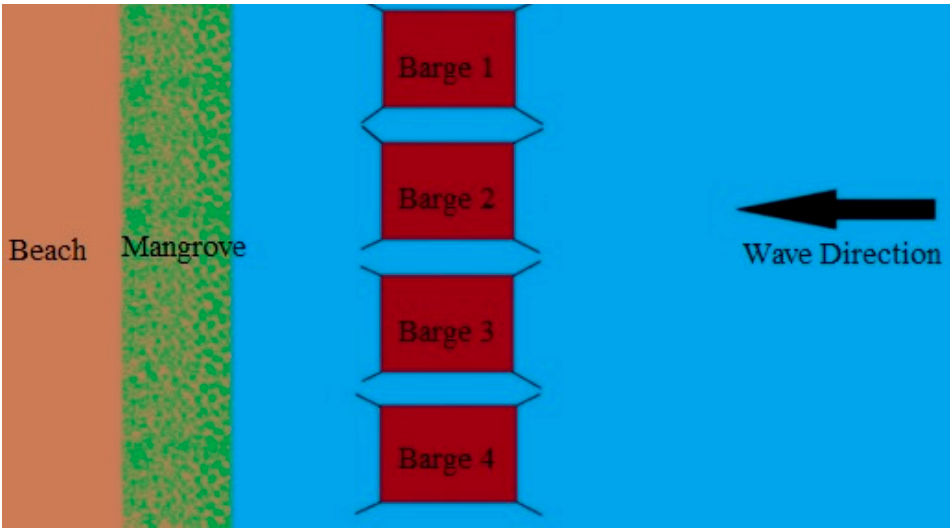
Figure 7. Moored barges and mangroves along the length of the beach in plain view.